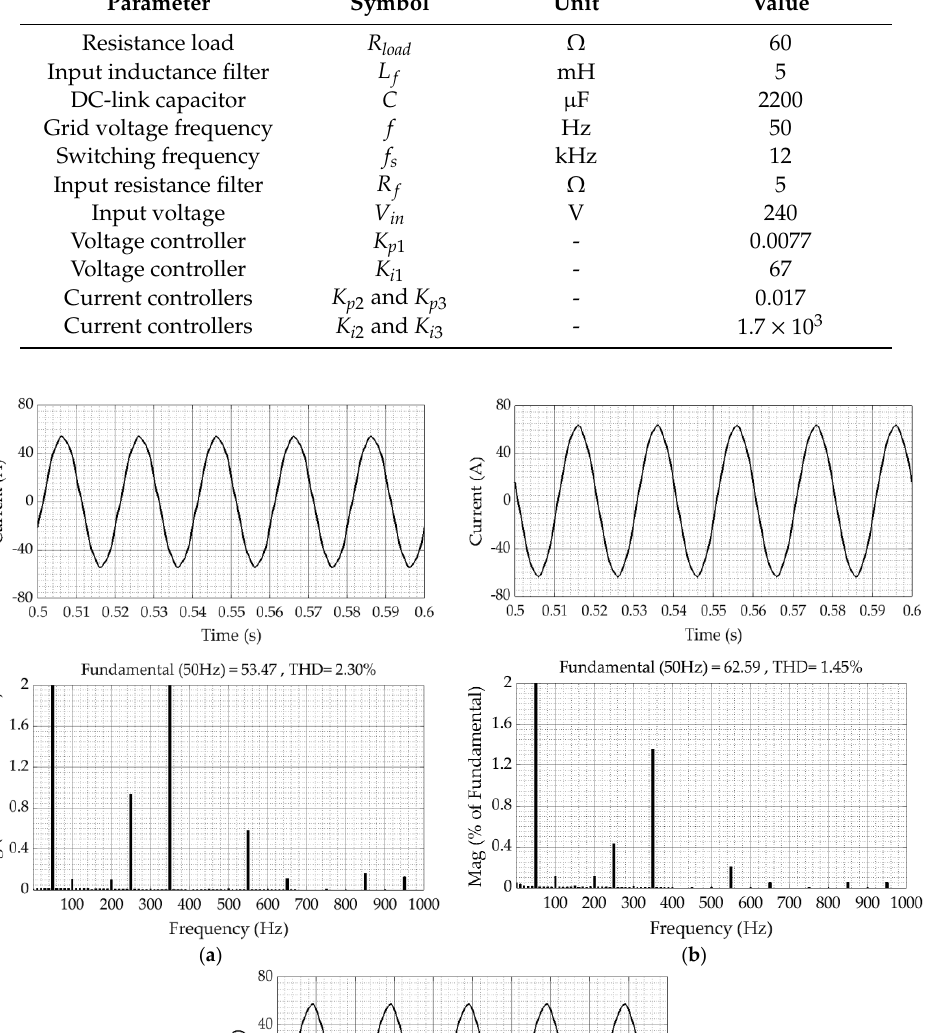
Figure 11. The input current waveform for Level 2 charging (Phase A).